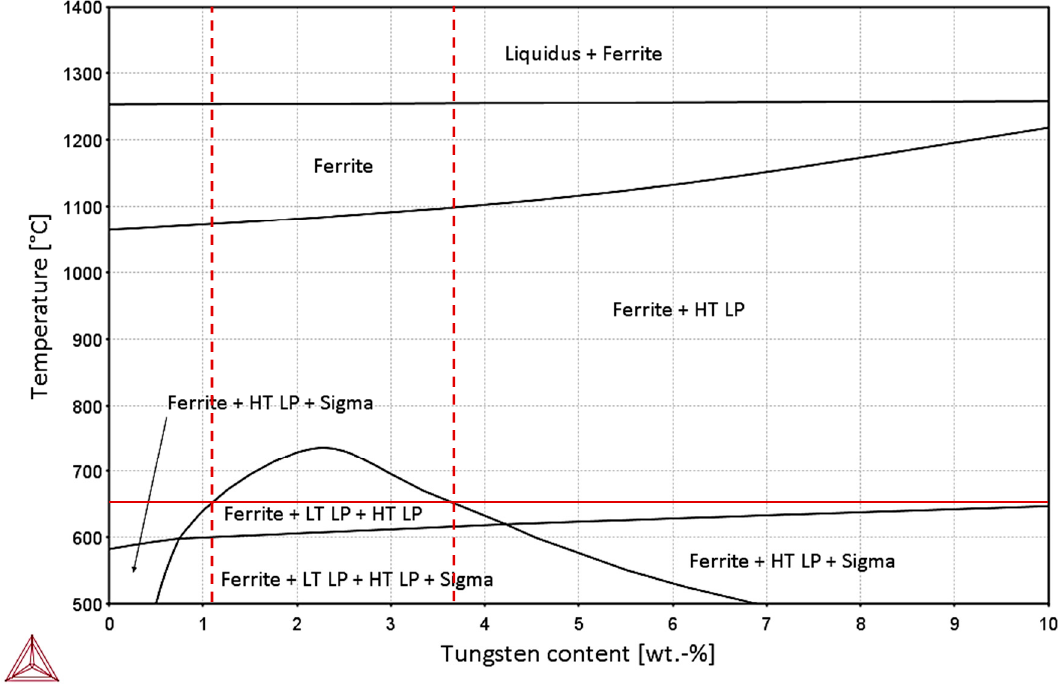
Figure 3. Results of thermodynamic equilibrium calculations of phase diagram (LT LP ‐ Low Temperature Laves Phase, HT LP ‐ High Temperature Laves Phase) as a function of temperature and tungsten content (ThermoCalc ® , database TCFE8, nominal chemical composition of 17 wt. % Cr, 0.2 wt. % Mn, 0.25 wt. % Si, and 1 wt. % Nb).